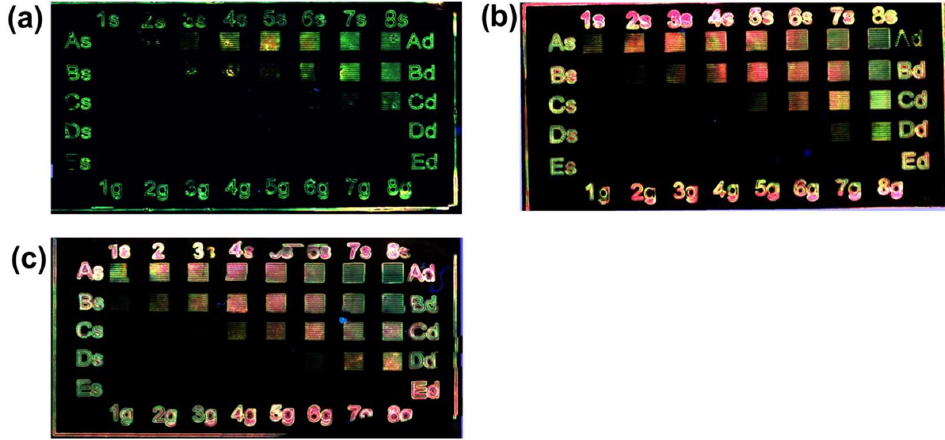
Figure 5. Photo of the Laser treated film under epi-fluorescent microscope (excitation with UV filter) at different PMMA concentration: ( a ) 100 mg/mL, ( b ) 200 mg/mL and ( c ) 300 mg/mL. The Cd(ISA) 2 is 40 mg/mL. The laser parameters and the doses used are reported in Table 1.